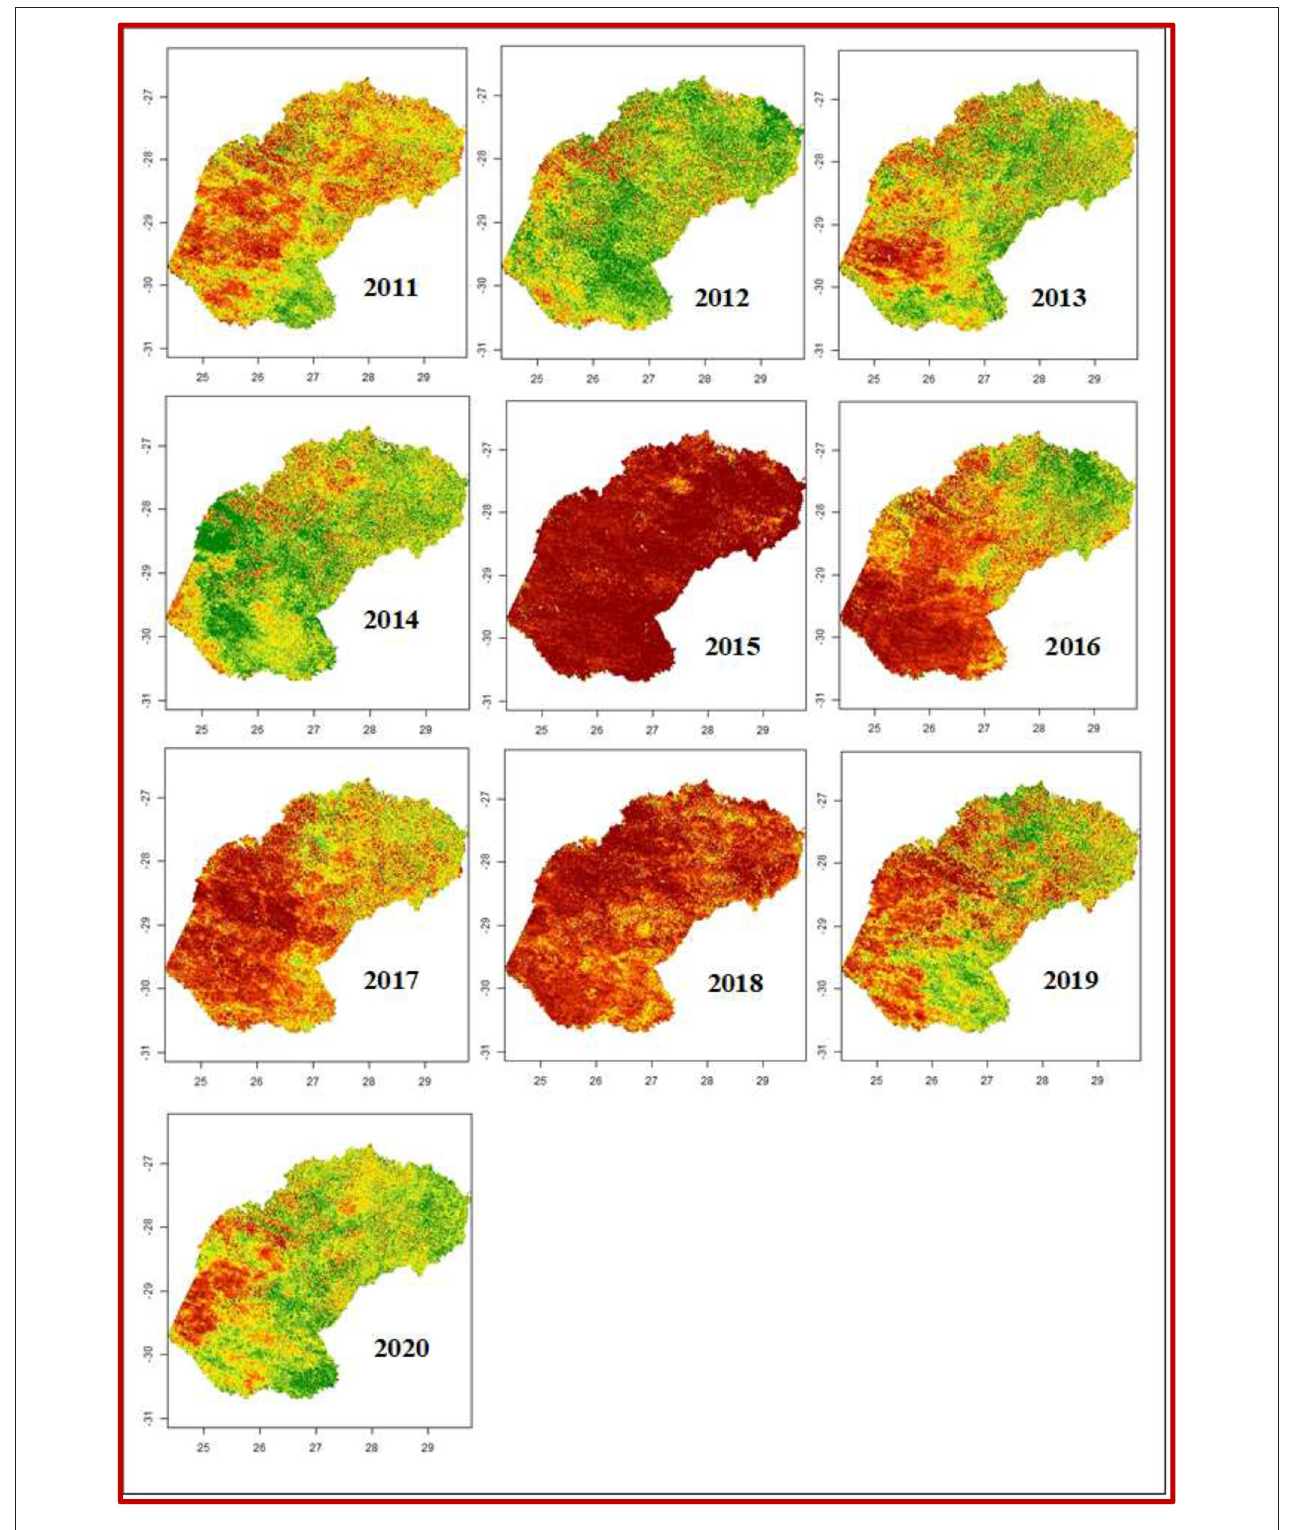
FIGURE 3 | Drought events for the year